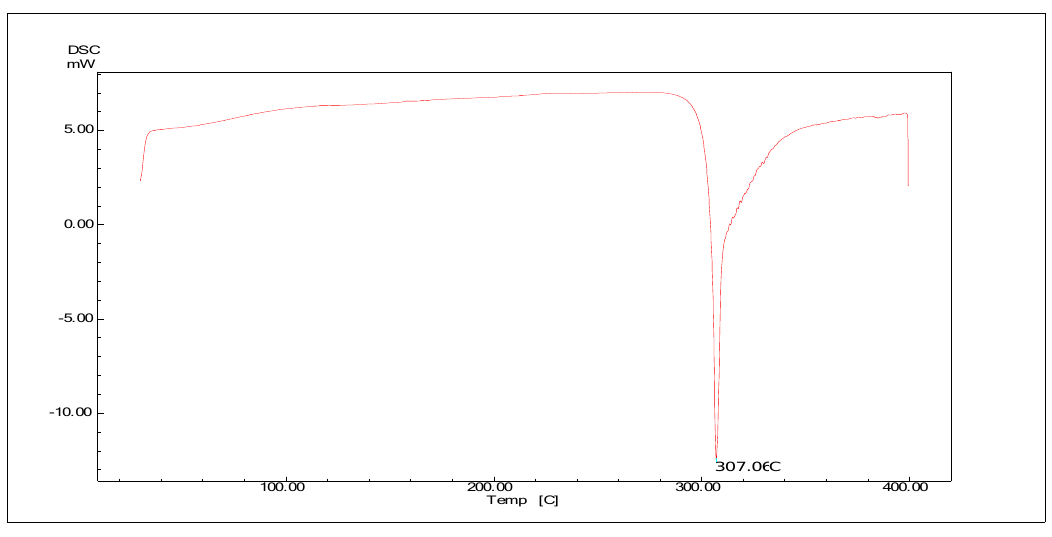
Figure (3) DSC thermogram of pure rebamipide powder